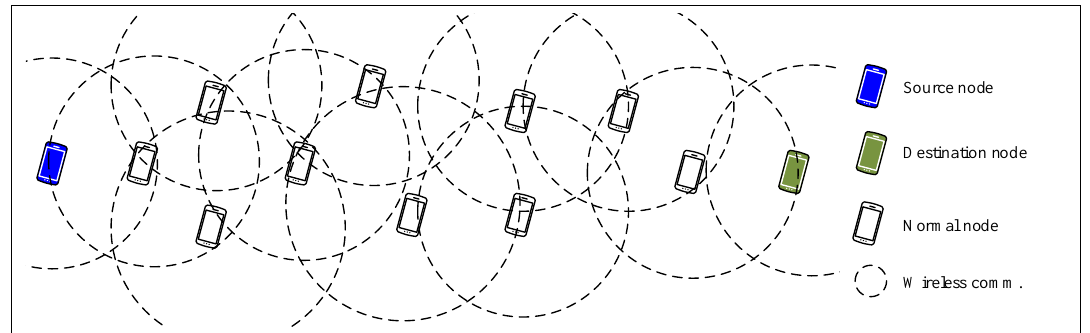
Figure 3. Evaluation algorithm